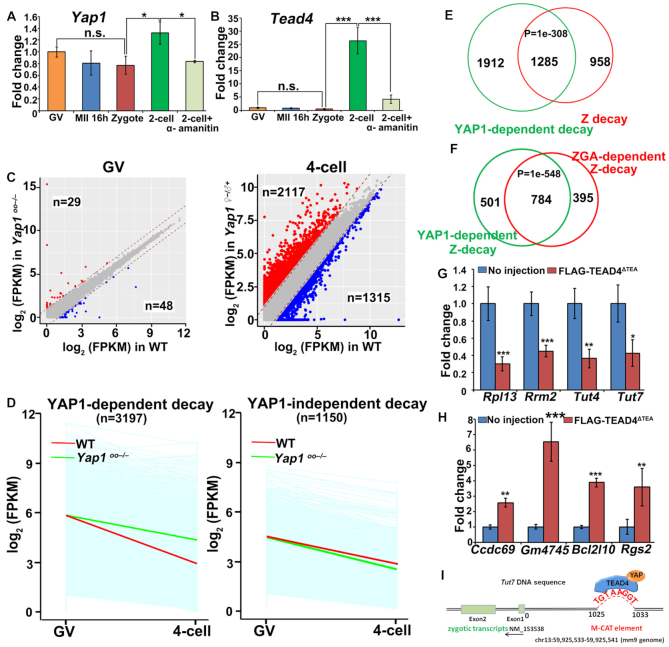
Role of maternal YAP1 and zygotic TEAD4 in the Z-decay pathway of mouse embryos. (A, B): RT-qPCR results showing the relative mRNA levels of Yap1 (A) and Tead4 (B) in GV oocytes, MII oocytes after 16 h of hCG injection, zygotes, two-cell embryos, and α-amanitin-treated embryos. The embryos were treated with α-amanitin (25 ng/μl), and then cultured to the 2-cell stage until 43 h after the hCG injection. Error bars, s.e.m. *P < 0.05 and ***P < 0.001 by two-tailed Student's t-test. n.s.: non-significant. n = 3 biological replicates. (C) Scatter plot comparing transcripts between the WT and Yap1–/– oocytes (at the GV stage) and the four-cell embryos derived from these oocytes. Transcripts decreased or increased by >2-fold in Yap1–/– samples were highlighted in blue or red, respectively. (D) Degradation pattern of maternal transcripts in mouse embryos with or without maternal Yap1 knockout. Transcripts with FPKM (GV) > 2; FPKM (four-cell/GV) < 1/2 were selected for the analyses. Each light blue line represents the expression level of one gene. The middle red line represents the median expression level of the cluster. The green line represents the median expression level of the cluster after maternal Yap1 knockout. (E) Venn diagrams showing the overlap of Z-decay transcripts (FPKM (GV) > 2; FPKM (zygote/GV) ≥ 1/2; FPKM (2-cell/zygote) <1/2) and the maternal transcripts that were significantly accumulated in four-cell embryos derived from Yap1–/– oocytes (FPKM (4-cell/GV) < 1/2 in WT; FPKM (Yap1–/–/WT) >1 at the 4-cell stage). P = 1e–308 by two-tailed Student's t-test. (F): Venn diagrams showing the overlap of ZGA-dependent Z-decay transcripts (FPKM (GV) > 2; FPKM (zygote/GV) ≥ 1/2; FPKM (two-cell/zygote) < 1/2; FPKM (two-cell/zygote) ≥ 1/2 after α-amanitin treatment) and the maternal YAP1-dependent Z-decay transcripts, i.e. the overlapping transcripts in (E). P = 1e–548 by two-tailed Student's t-test. (G–H) RT-qPCR results showing the relative mRNA levels of zygotic transcripts (G) and Z-decay transcripts (H) in two-cell embryos overexpressing a dominant negative form of TEAD4 (FLAG-TEAD4ΔTEA) by mRNA microinjection at the zygote stage. Error bars, s.e.m. *P < 0.05, **P < 0.01 and ***P < 0.001 by two-tailed Student's t-test. n = 3 biological replicates. (I) Illustration showing a putative TEAD-binding site (M-CAT element) of the mouse Tut7 gene in mm9 genome. M-CAT element locates at 1025 bp upstream of Tut7 transcription start site, from 59 925 533 to 59 925 541 on the chromosome 13.